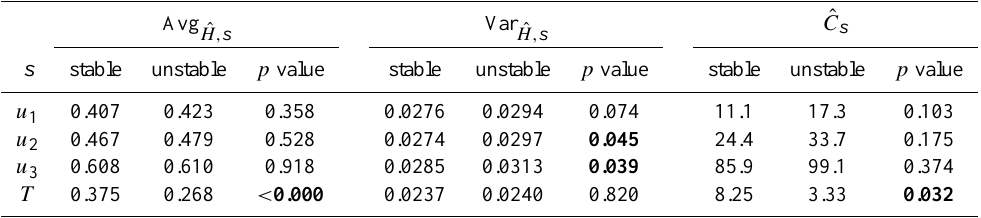
Table 3. Summary of the sample averages and variances for three velocity and temperature signals in terms of average and p value for stable and unstable runs using two-sample t-tests is shown. The boldfaced numbers represent significance with significance level 0 . 05.